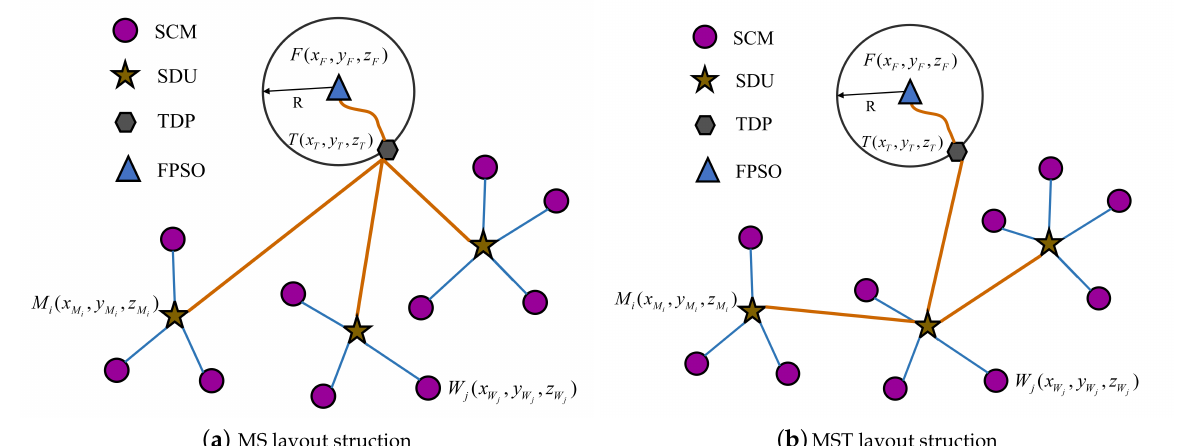
Figure 2. Top view of two pipeline layout